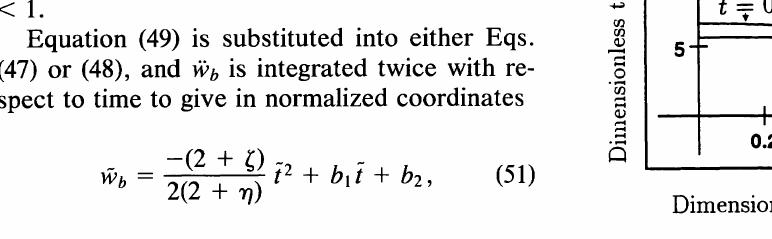
FIGURE 7 Normalized transient velocity profiles within the central